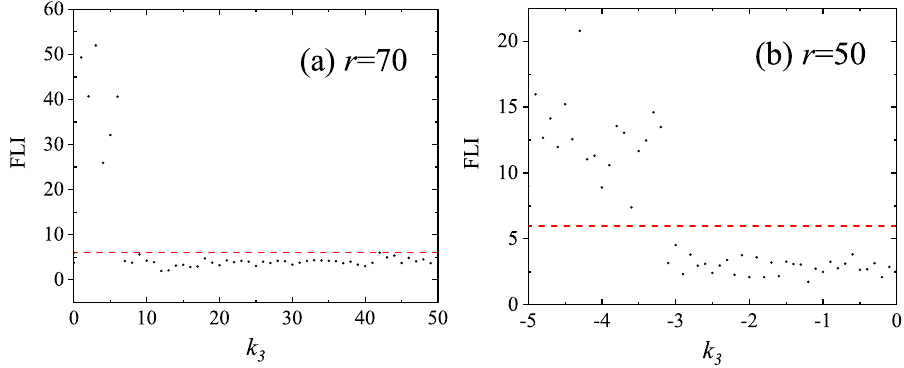
Figure 14. Dependence of FLI on the positive deformation parameter k 3 . The other parameters are the same as those in Figure 13. ( a ): E = 0.995, k 3 > 0 and the initial separation r = 70; when k 3 > 6, chaos begins to disappear. ( b ): E = 0.9945, k 3 < 0 and the initial separation r = 50; when k 3 < − 3.2, the chaotic properties are